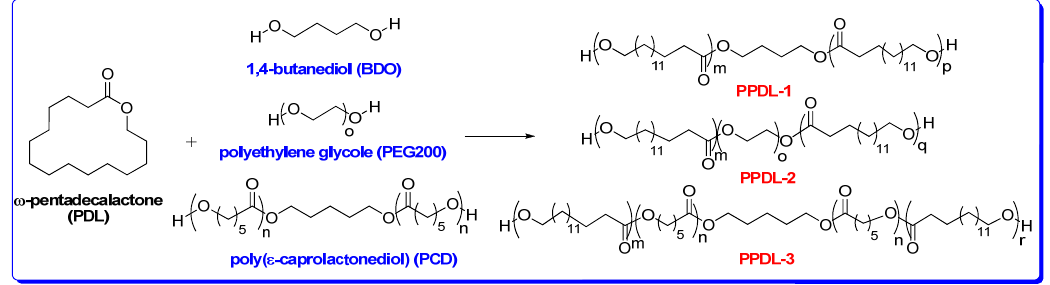
Table 2. The applied PDL/initiator ratio, catalyst amount, obtained conversion, polymerization degree, and molecular weight determined by NMR of PDL polymerization.